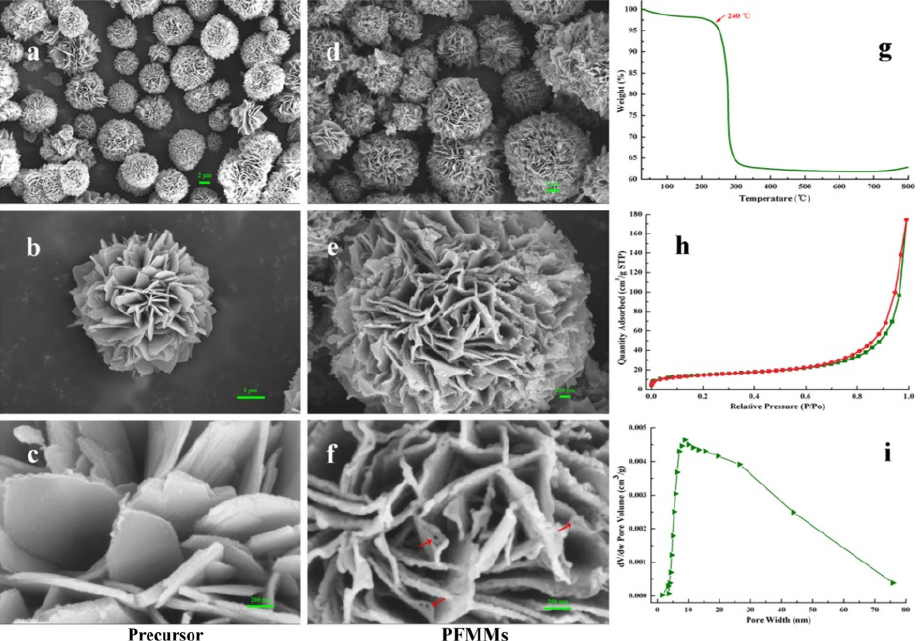
Figure 6. SEM micrographs and properties of PFMMs and its precursor. ( a – c ) PFMMs precursor. Their scale bars are 2 μ m, 1 μ m, and 200 nm, respectively. ( d – f ) PFMMs. Their scale bars are 1 μ m, 1 μ m, and 200 nm, respectively. ( g ) TGA curve of PFMMs precursor. ( h ) N 2 adsorption–desorption isotherm. ( i ) Pore size distribution of PFMMs. Reproduced with permission from [66], the American Chemical Society, 2020.